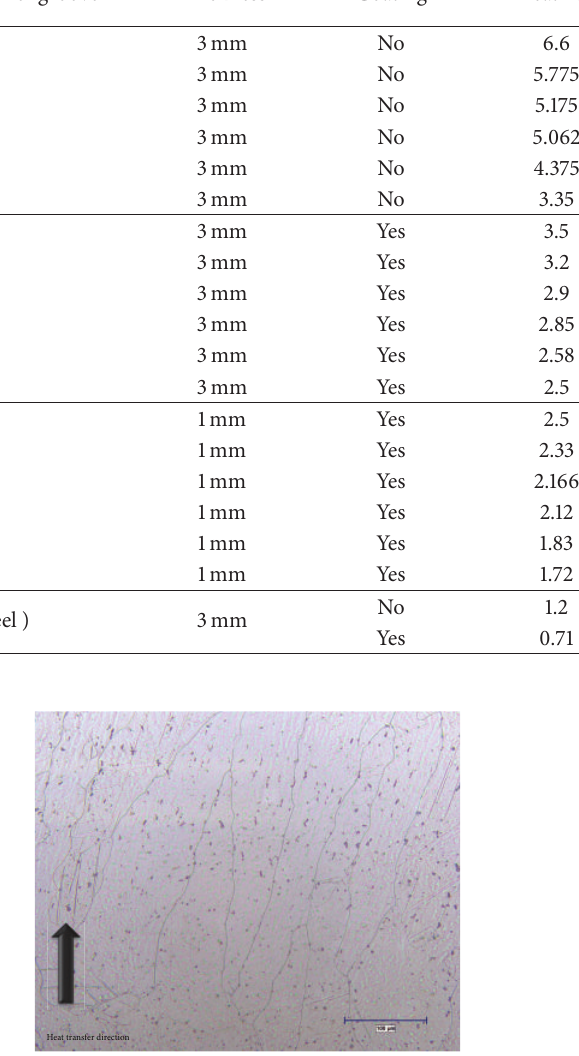
Figure 7: Directional grain growth because of air pockets at the melt/mould interface, × 200.